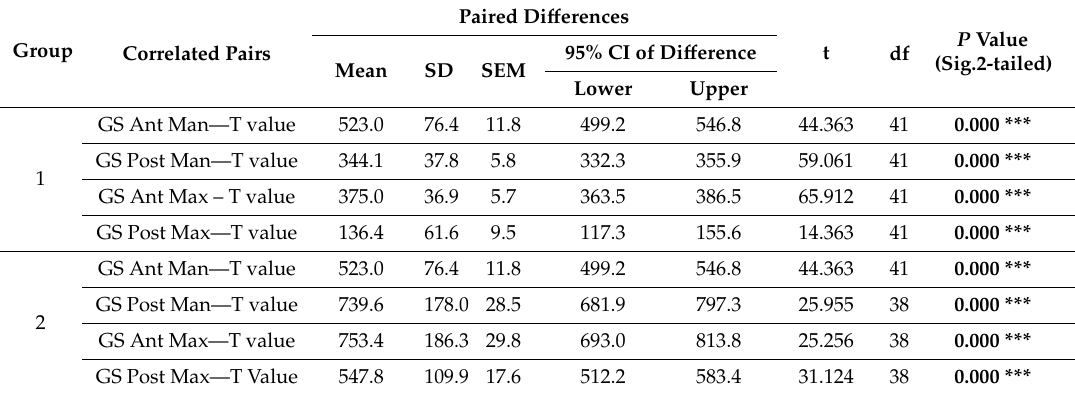
Table 4. Paired sample t -test for associations between T value and GS values at di ff erent jaw regions within each group.